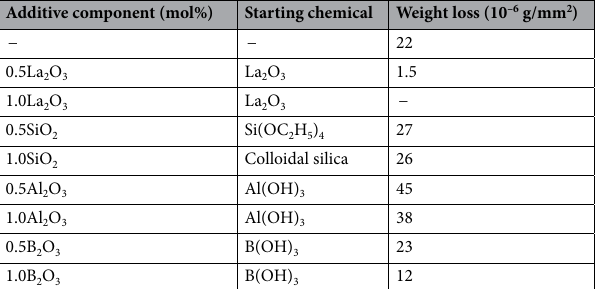
Table 2. Chemical compositions and weight loss of KSP glasses after the immersion test at 50 °C for 72 h. However, the 1.0La 2 O 3 -doped KSP glass was not obtained because of strong bubbling during the heat treatment at 500 °C.